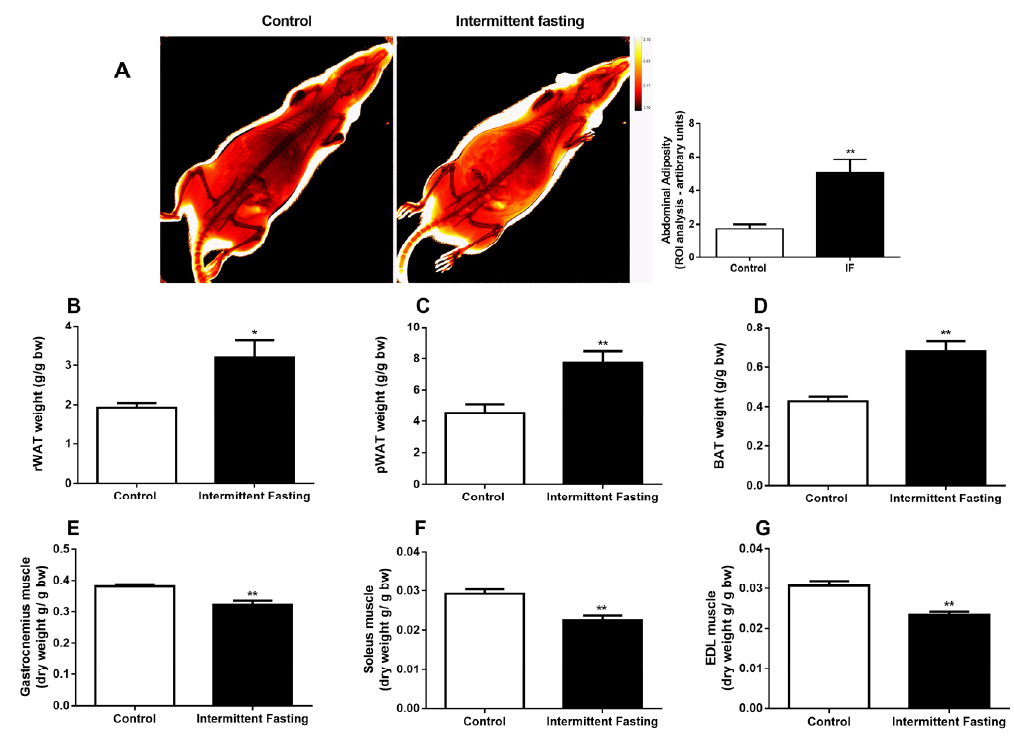
Figure 4. ( A ) Dual energy x-ray absorptiometry (DEXA), ( B ) retroperitoneal, ( C ) perigonadal, and ( D ) brown adipose tissue weight. ( E ) Dry gastrocnemius weight, ( F ) Soleus, and ( G ) Extensor digitorum longus (EDL) muscle of Wistar rats submitted to IF for 12 weeks. The results are presented as the means ± standard error of the mean (SEM) with 10 di ff erent animals for each group. * p < 0.05 and ** p < 0.005 compared to the control of the same period, as indicated by Student’s t